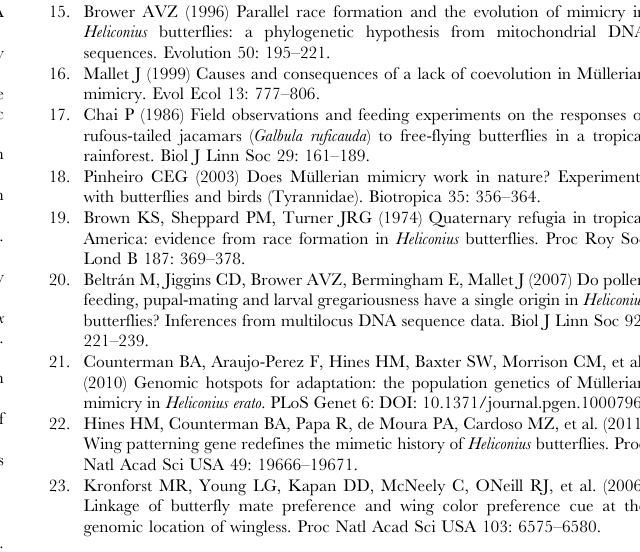
Figure S1 Bayesian coalescent phylogeny for the Heliconius with country level populations of H. erato and H. melpomene . Branch labels give posterior probabilities, the axis indicates time (Mya) based on substitution rate calibration, and scale bars show 95% Bayesian confidence intervals for the mean node age. Figure S2 Bayesian coalescent phylogeny for the Heliconius with country level populations of H. erato and H. melpomene , labelled as for Figure S1 and showing a time axis based on node age calibration. Figure S3 Bayesian coalescent phylogeny for the Heliconius with morph level populations of H. erato and H. melpomene , labelled as for Figure S1 and showing a time axis based on substitution rate calibration. Figure S4 Bayesian coalescent phylogeny for the Heliconius with morph level populations of H. erato and H. melpomene , labelled as for Figure S1 and showing a time axis based on node age calibration. Figure S5 Phylogenies for H. erato (left) and H. melpomene (right) reproduced from [30] and corresponding to cophylogenetic analysis ‘‘Quek et al., 2010 AFLP’’ in Table 1. H. erato / H. melpomene co-mimics sampled from the same country are indicated by grey lines. Taxon labels indicate the sampled biogeographic region (East or West of the Andes), and country (abbreviations correspond to Figure 2). Shaded circles indicate the significance of a pairwise distance correlation test conducted for the shaded node (with p values corresponding to the key). Figure S6 Maximum likelihood phylogenies independently estimated for H. erato (left) and H. melpomene (right) based on the 10-gene dataset of [22], corresponding to cophylogenetic analysis ‘‘Hines et al. 2011, 10-genes’’ in Table 1. Taxon labels indicate the sampled biogeographic region (abbreviations are: Am Amazon, Ca Caribbean, Ch Chocoan-Parana), and country